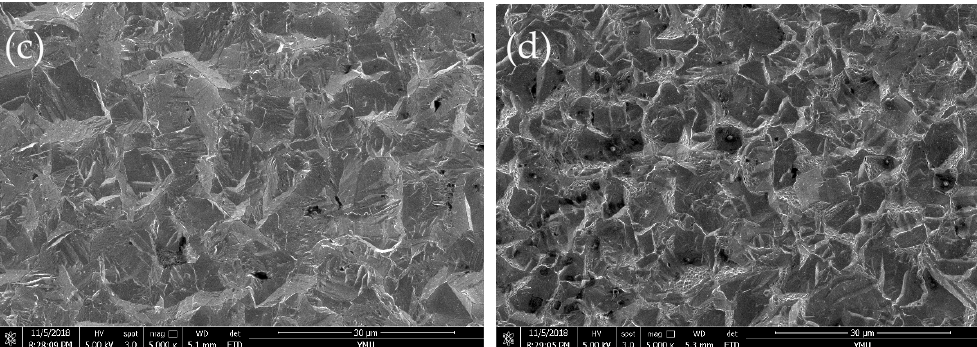
Figure 7. SEM images of Fe–Ni alloys electrodeposited from the chloride baths that contained 0.3 M Ni 2+ ions at ( a ) 15 A · dm − 2 , 10 # , ( b ) 20 A · dm − 2 , 11 # , ( c ) 25 A · dm − 2 , 12 # , and ( d ) 30 A · dm − 2 , 13 # .